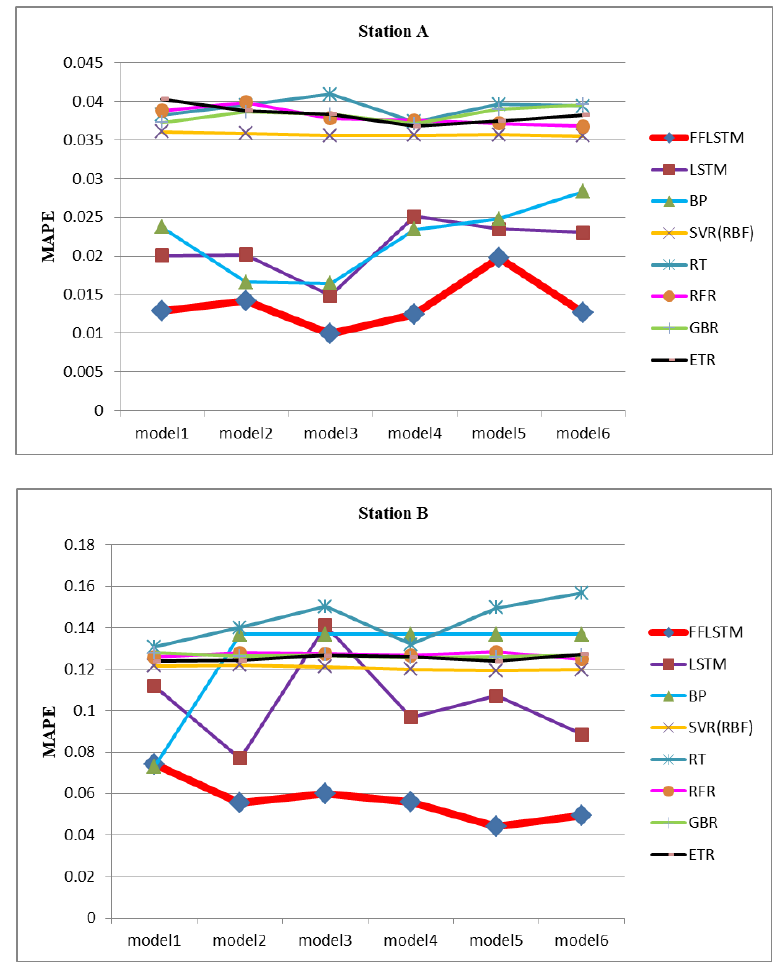
Figure 6. Evaluation of the results of the mean absolute percentage error (MAPE) for station A and B, respectively.